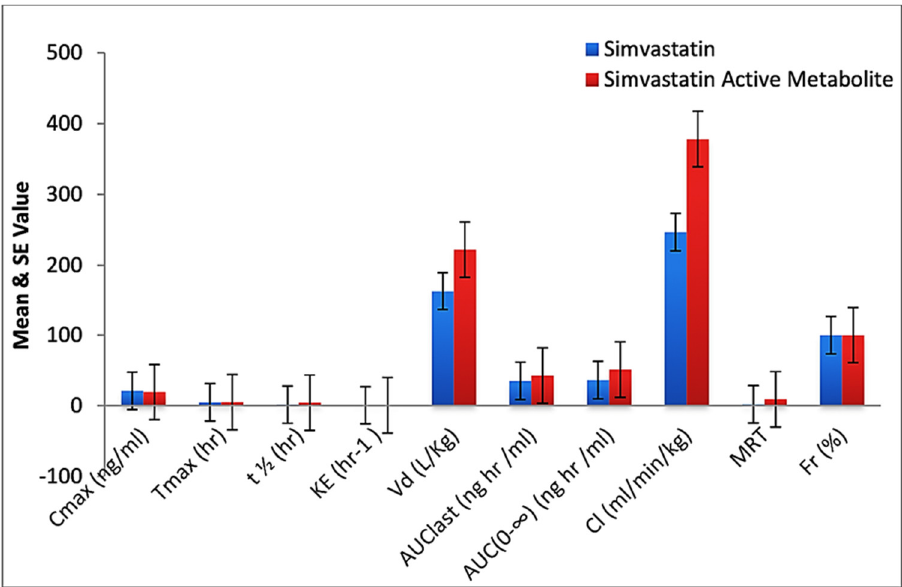
Figure 7. Comparison of pharmacokinetic parameters of simvastatin and simvastatin active metabo- lite in plasma of standard-treated rabbit.